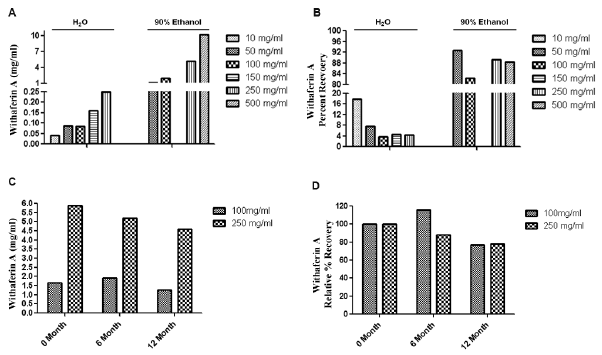
Figure 1. Withaferin A recovery in sWRE. sWRE powder was dissolved in different solvents and the concentration (A) and recovery rate (B) of Withaferin A in sWRE was measured by HPLC. The stability of Withaferin A in sWRE (90% EtOH stock solution) over time is shown in a bar graph with the absolute (C) and relative (D) Withaferin A concentration.